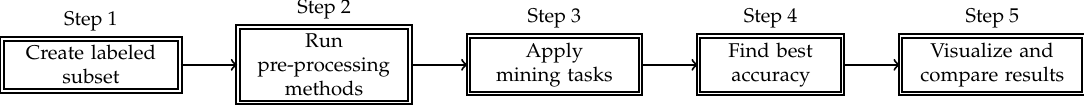
Figure 1. Methodology for analyzing the best pre-processing methods prior to text mining tasks.